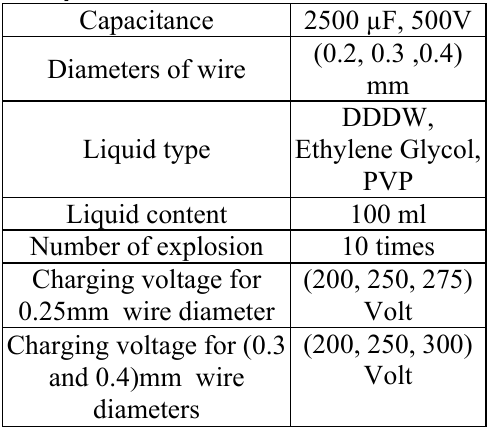
Table 1: The experimental conditions were used for preparation copper